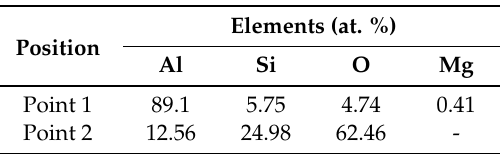
Table1. EDX element analysis of Point 1 and Point 2 in Figure 2b showing the chemical compositions in the SLM-processed Al 2 Si 4 O 10 /AlSi10Mg composites. Elements (at. %) Position Al Si Mg O